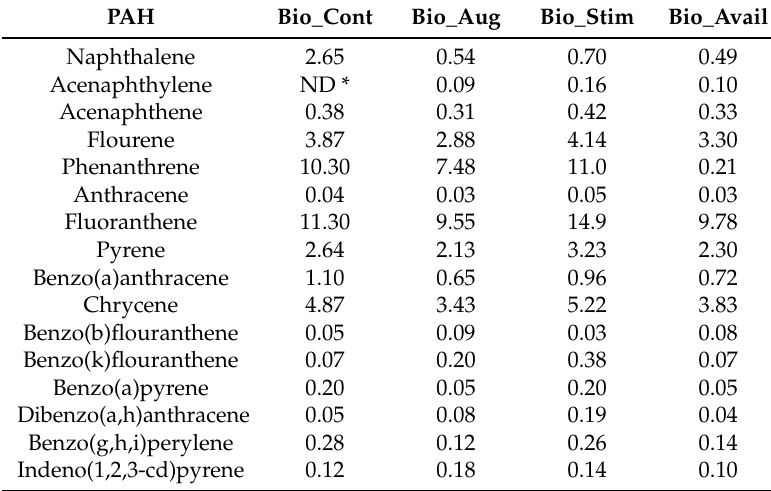
Table 2. Residual polyaromatics (PAH, in mg/kg) after treatment.